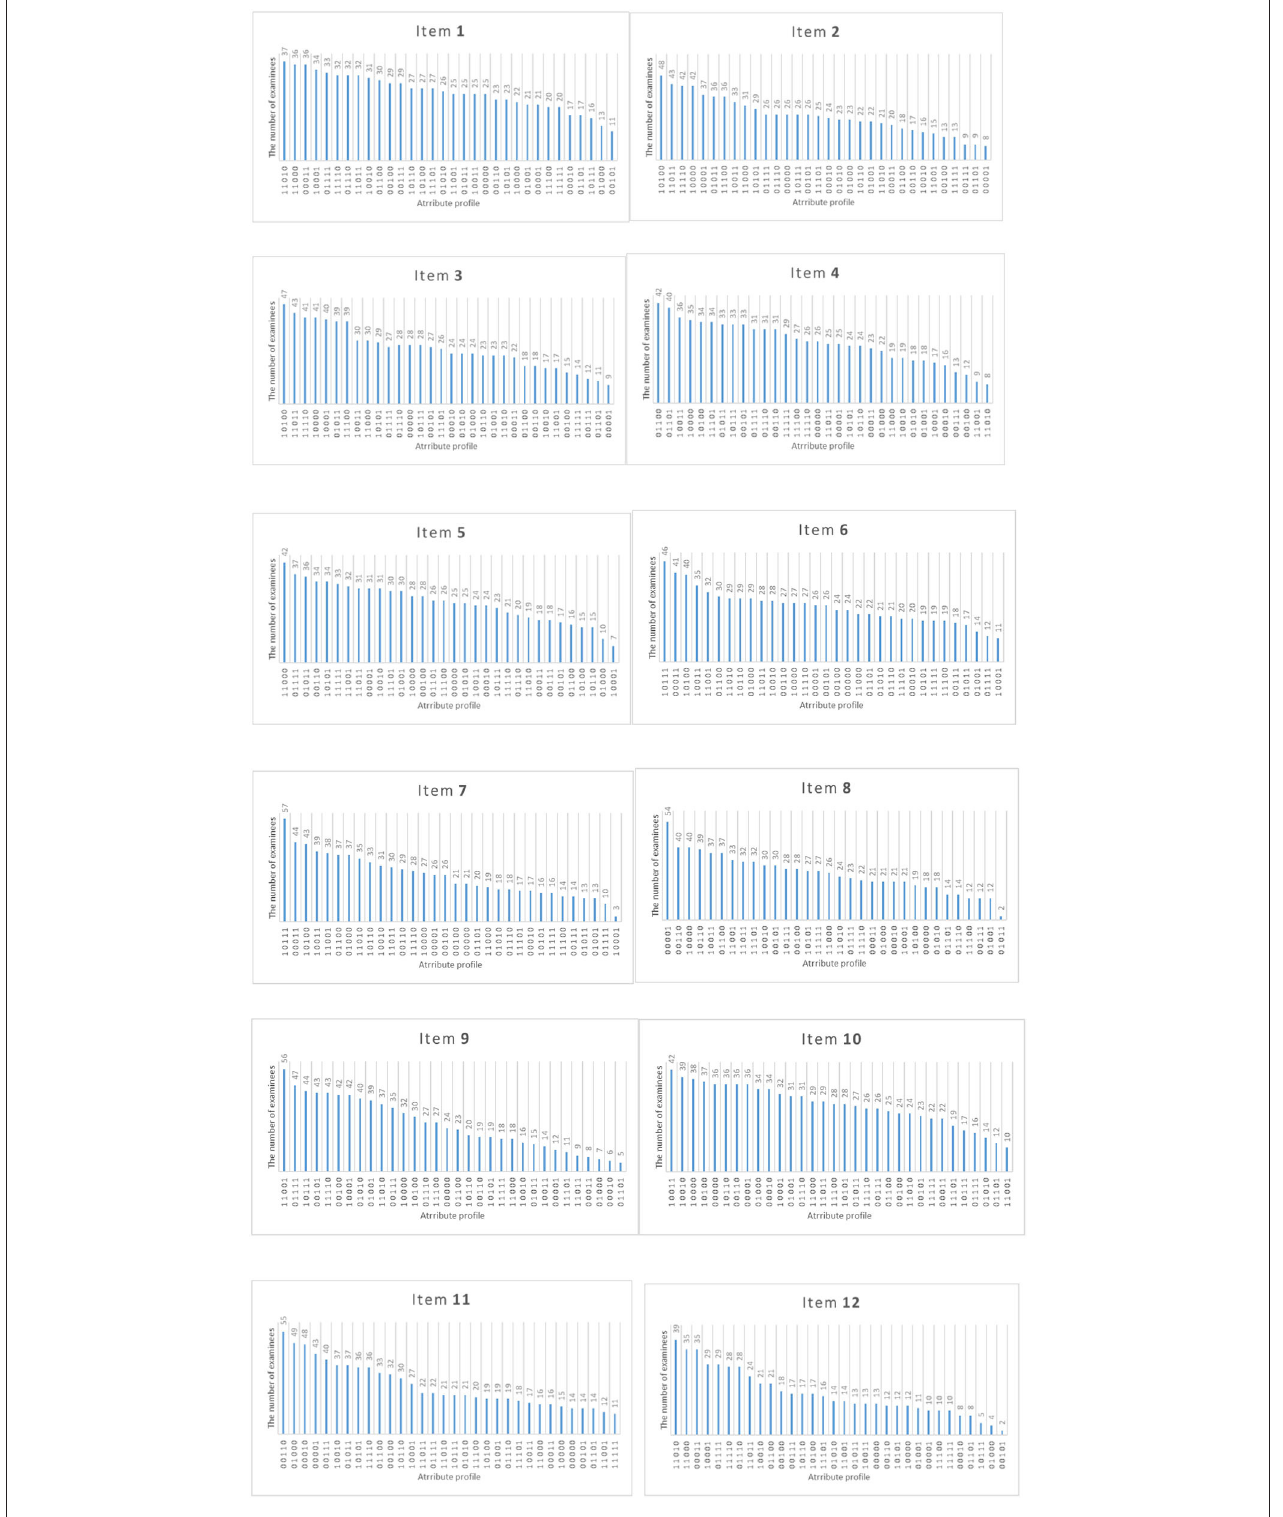
FIGURE 8 | The number of examinees in various attribute mastery pattern assigned to each item under the Shannon entropy allocation strategy.